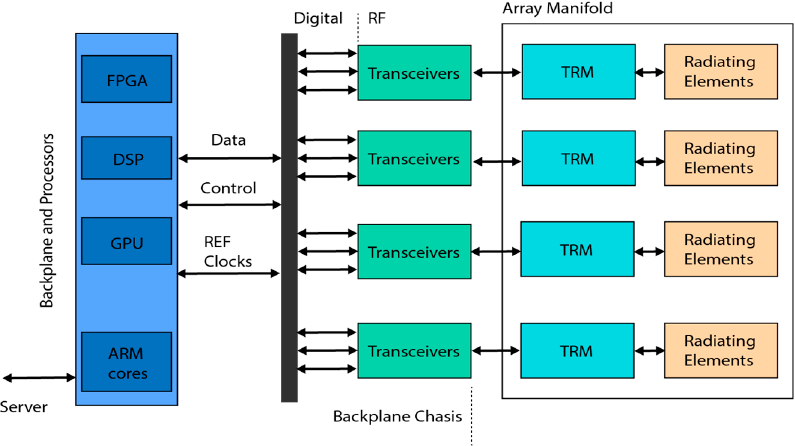
Figure 1. Top-level system digital array system concept.